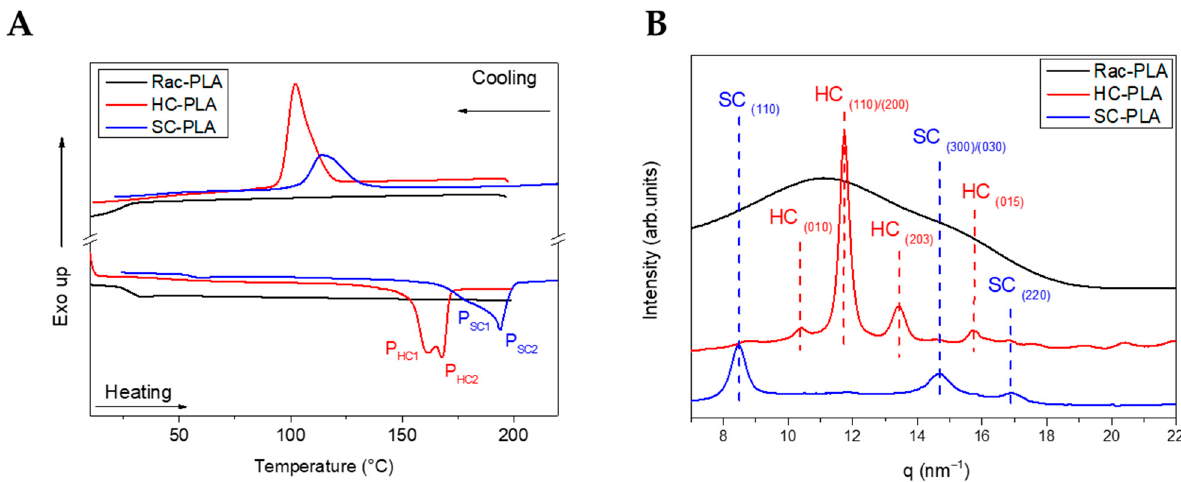
Figure 1. DSC thermograms ( A ) and WAXS patterns ( B ) of bulk polymers at room temperature.